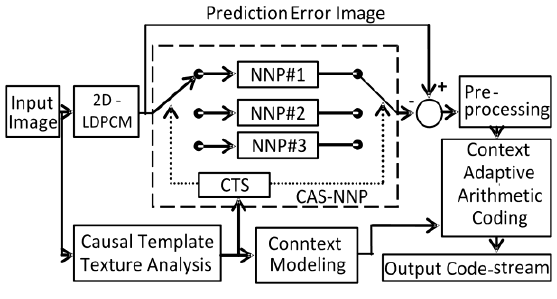
Fig. 3. Flow diagram of the proposed lossless image compression using the DL-DPCM